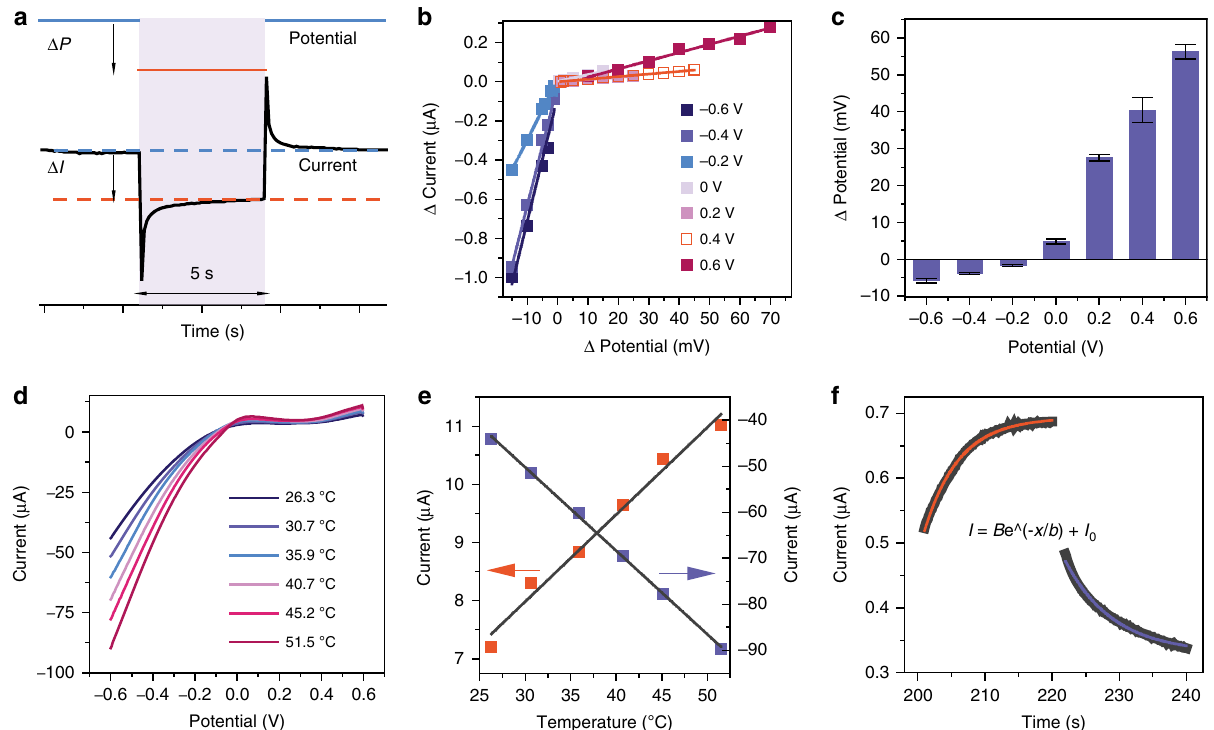
Fig. 3 The potential-step and temperature-control experiments. a The typical i − t curve in response to a potential step, Δ I is the current change induced by the step potential ( Δ P ) after a 5 s interval to stabilize. b The change of current as a function of the step potential at various applied potentials. c Step potential required to achieve a similar current change as was achieved with the RRC at various applied potentials. d The I – V curve of the Au nanoelectrode array at various temperature. e The current at − 0.6 V (blue) or 0.6 V (red) as the function of the temperature. f The fi tting of the SRC at 0.6 V, the black dots are the experimental result (0.6 V 200 – 240 s); the red lines are the fi tted functions under illumination; the blue line are the fi tted functions in the dark. The error bars represent the standard